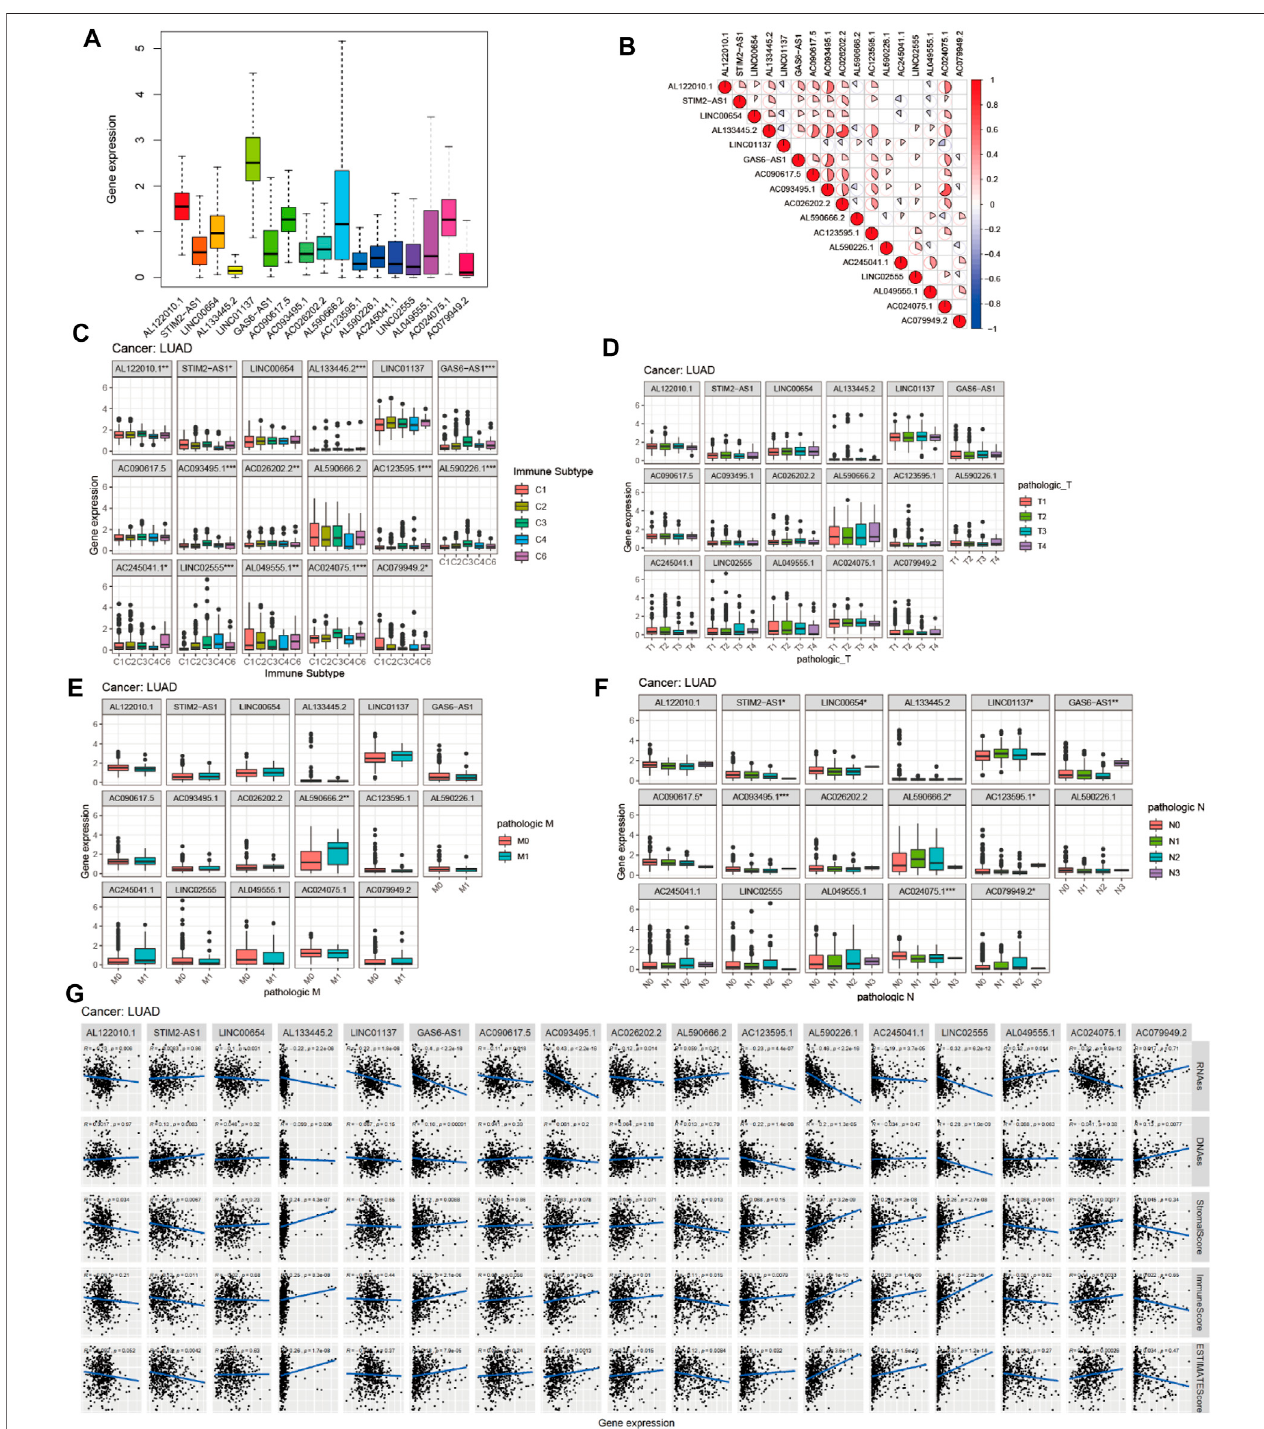
FIGURE 13 | Expression, clinical correlation, and immune microenvironment analyses of prognostic m 6 A-related lncRNAs in LUAD. (A) Expression of 17 prognostic m 6 A-related lncRNAs in LUAD. (B) Correlation analysis of 17 prognostic m 6 A-related lncRNAs. (C) Boxplot of 17 prognostic m 6 A-related lncRNAs in six LUADimmunesubtypes. (D – F) Boxplotsof17prognosticm 6 A-relatedlncRNAsandclinicalfeaturesinLUAD. (G) Correlationsbetweentheexpressionof17prognostic m 6 A-related lncRNAs and tumor stemness scores (based on RNA methylation and DNA methylation), immune score, estimate score, and stromal score in LUAD.